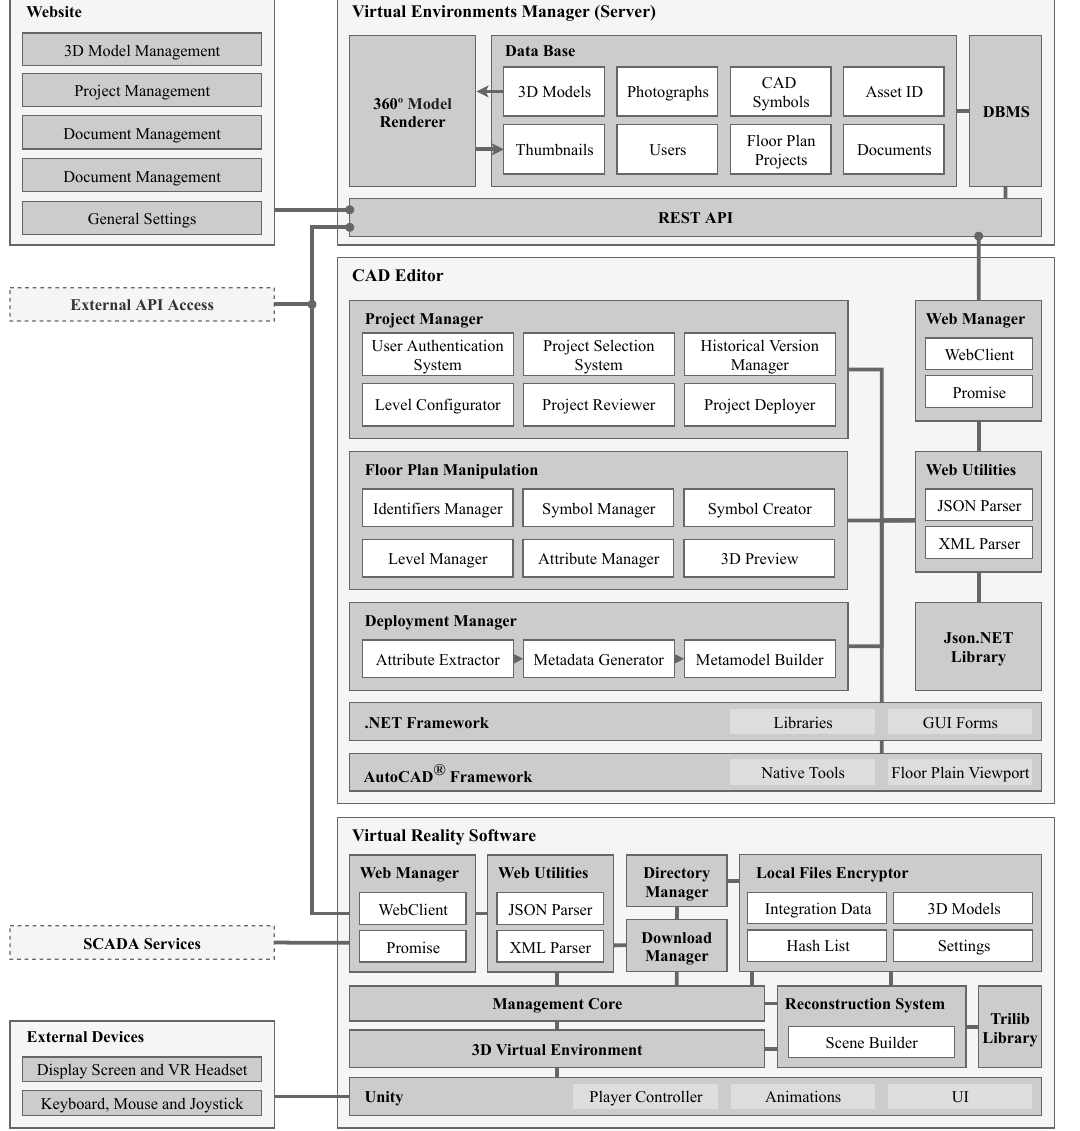
Figure 2. Detailed architecture of the Authoring